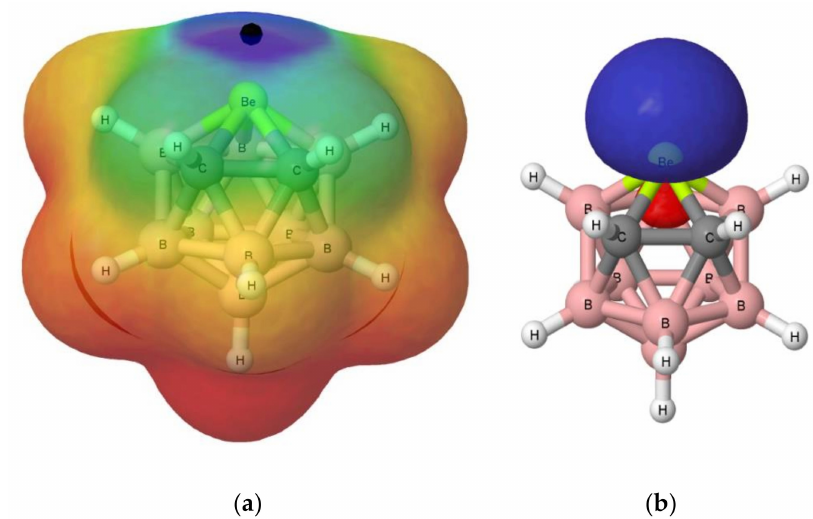
Figure 4. ( a ) Molecular electrostatic potential (MESP) on the 0.001 au electron density of B 9 H 11 C 2 Be ( a ). Regions with MESP > 0.1 au are indicated with blue color and MESP < − 0.015 au with red color. The location of the V s, max is indicated with a black sphere; ( b ) shows the LUMO orbital for the same